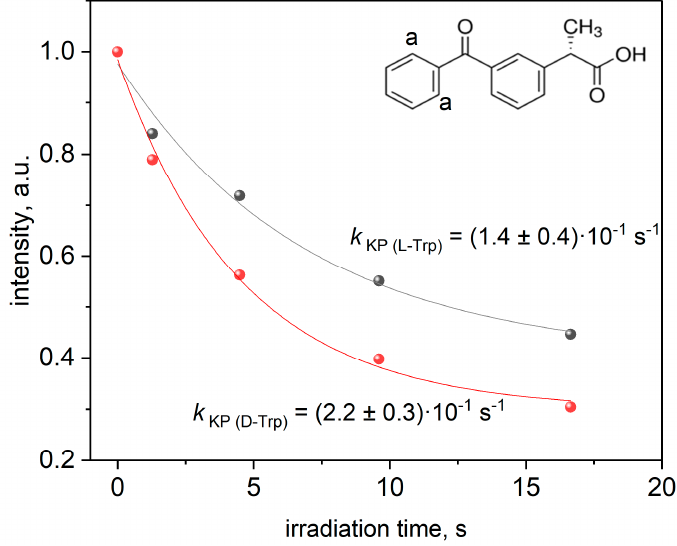
Figure 8. Rate constants of the decomposition of KP and L/D-Trp under irradiation in DHPC/DMPC bicelles.